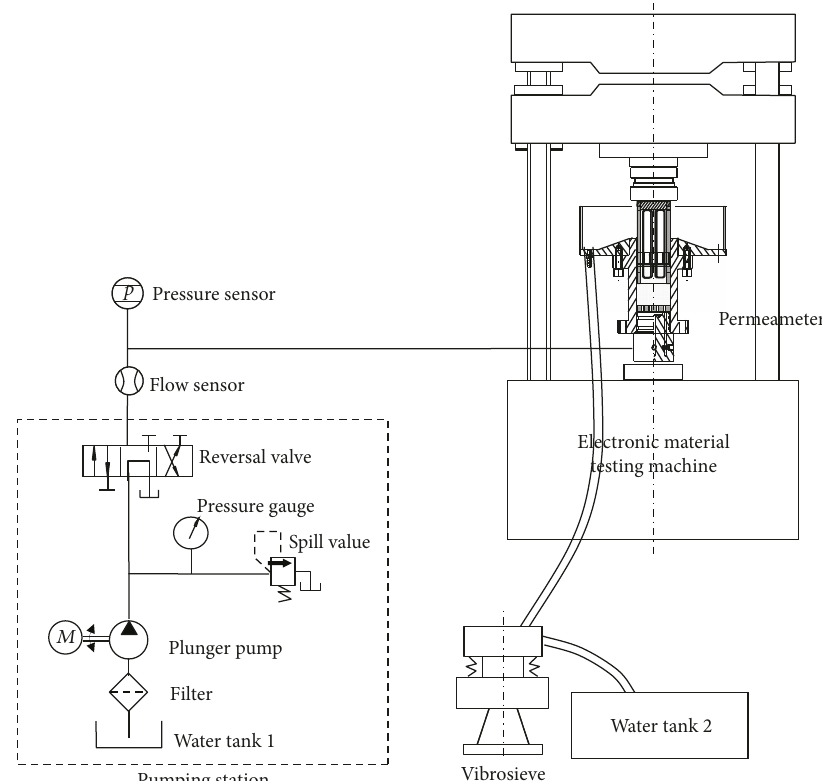
Figure 1: Schematic of the experimental